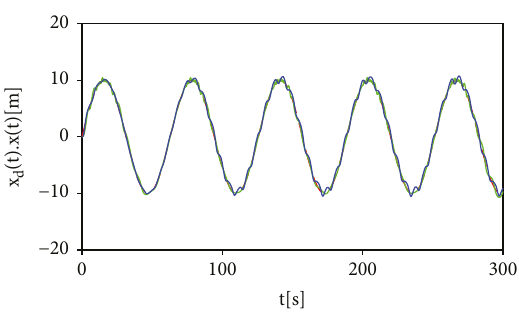
Figure 3: Position tracking trajectory.